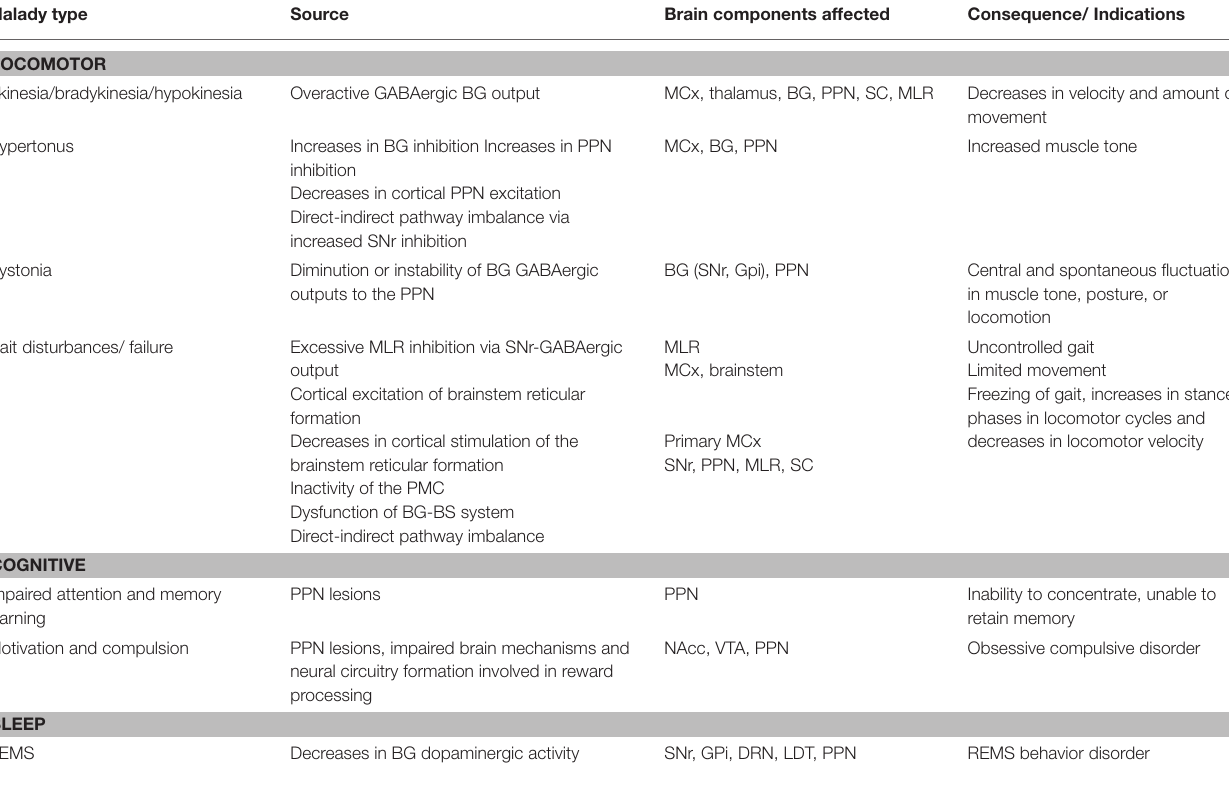
TABLE 1 | Maladies associated with the PPN in PD, the source and affected brain components, as well as its consequence/ indications. Malady